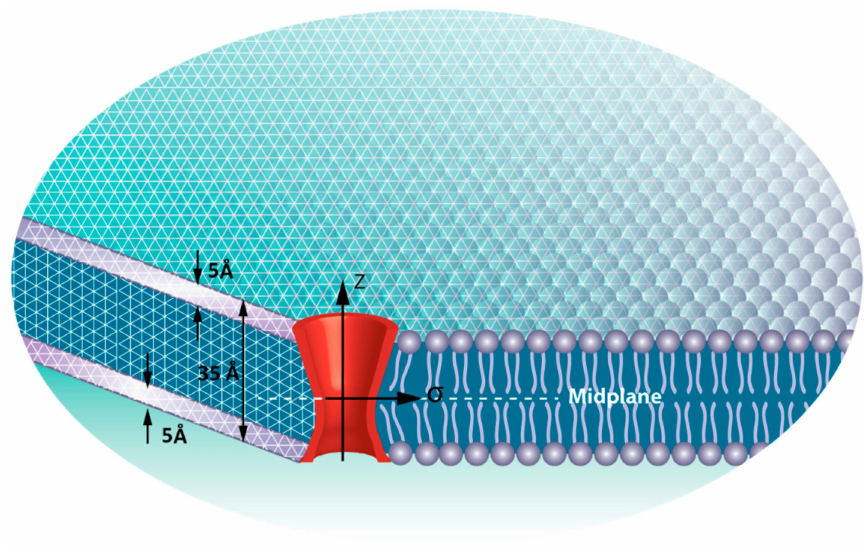
Figure 3. The FE model of the lipid bilayer and the incorporated MscL. The upper and lower layers represent the head groups and the core illustrates the tails of lipid bilayer. The thickness of the representative volume element (RVE) is 5